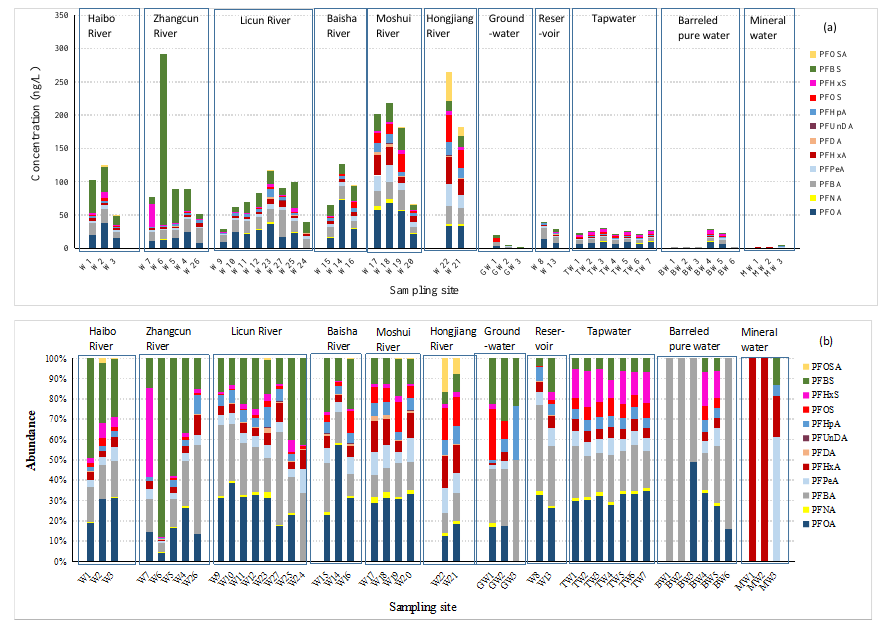
Figure 2. ( a ) Concentrations and ( b ) composition profiles of PFASs in different water matrices in Qingdao .